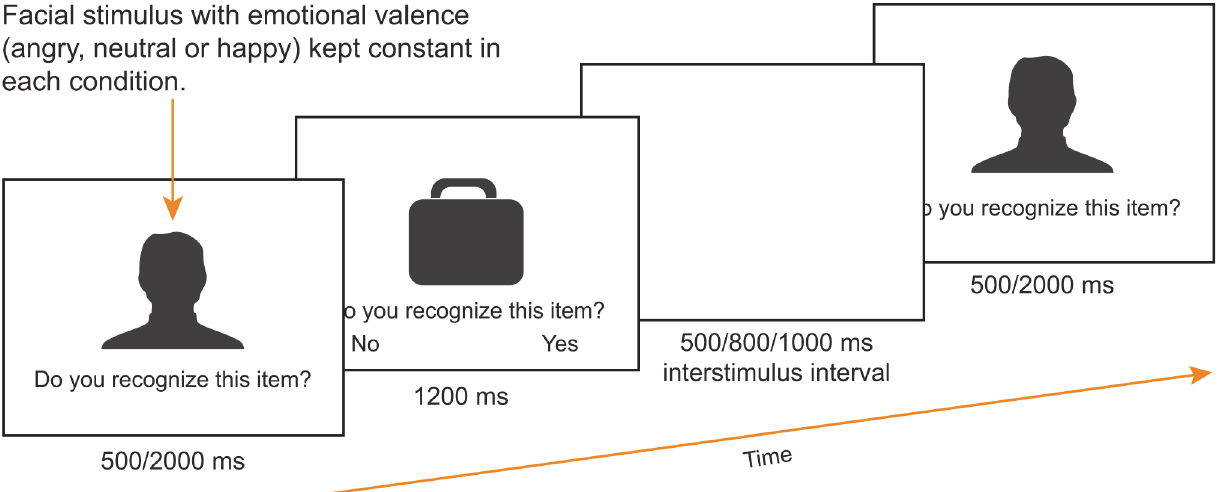
Fig 2. Em-RT-CIT conditions, in which the “ virtual investigator ” appeared before the presentation of each CIT